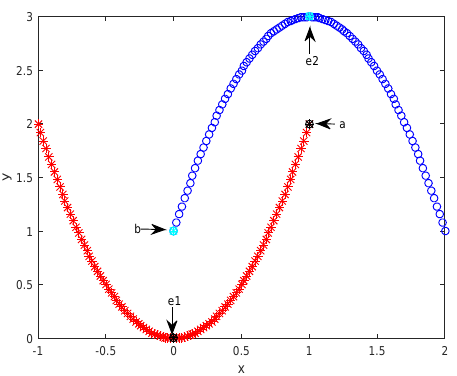
Figure 1. A toy example: 202 samples distributed in two curves. “e1” and “e2” are the exemplars of the lower cluster and upper cluster, respectively.